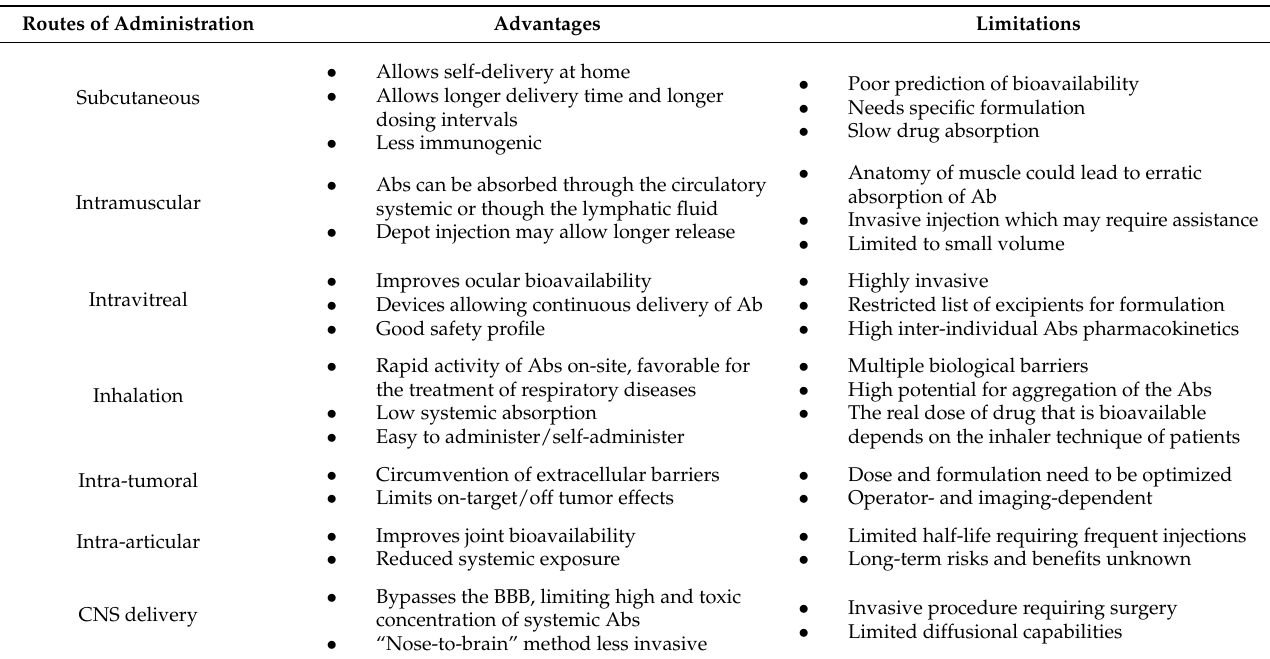
Table 9. Advantages and limitations of the different routes of administration for